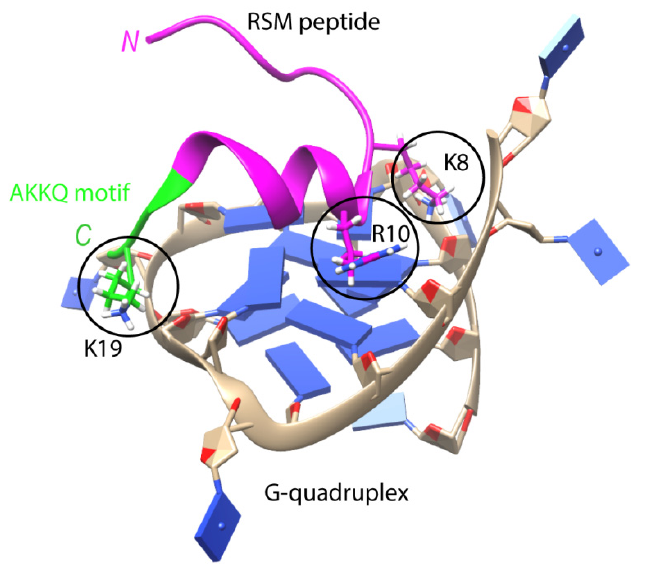
Figure 3. The structure of the complex between part of the DHX36 helicase (RSM peptide, in pink and green) and parallel and green) and parallel G4 with heterocyclic bases marked in blue (PDB 2N21 [90]). Three positively G4 with heterocyclic bases marked in blue(PDB 2N21 [90]). Three positively charged amino acid residues (K8, R10 and charged amino acid residues (K8, R10 and K19, circled) form electrostatic interactions with phosphate K19, circled) form electrostatic interactions with phosphate groups of G4. The amino acids of the α -helix stack with the groups of G4. The amino acids of the α -helix stack with the external G-tetrad, while the AKKQ motif external G-tetrad, while the AKKQ motif (in green) anchors the peptide in the G4 groove. (in green) anchors the peptide in the G4